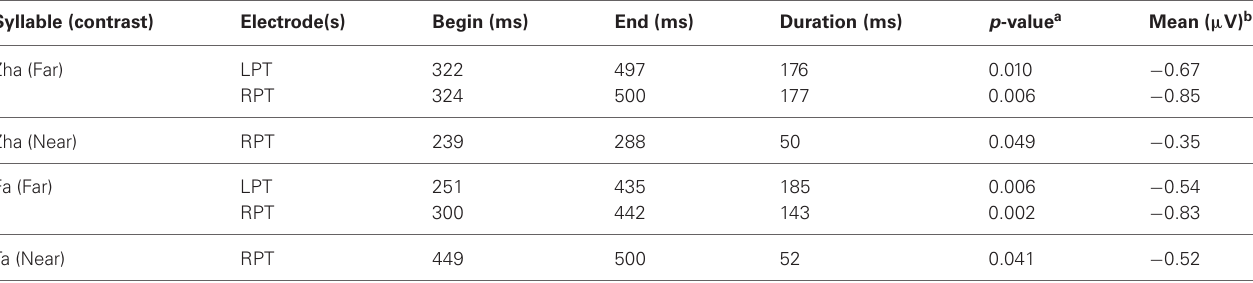
Table 2 | Summary of reliable